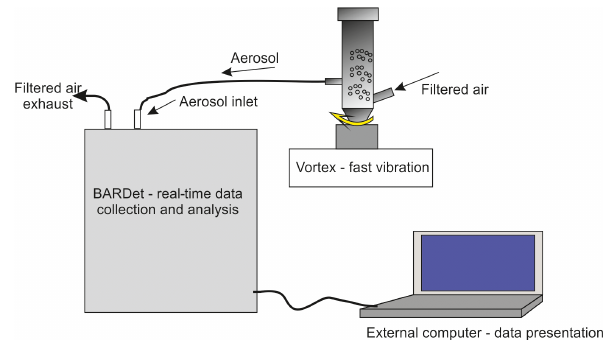
Figure 1. Setup of aerosol generation, data recording and